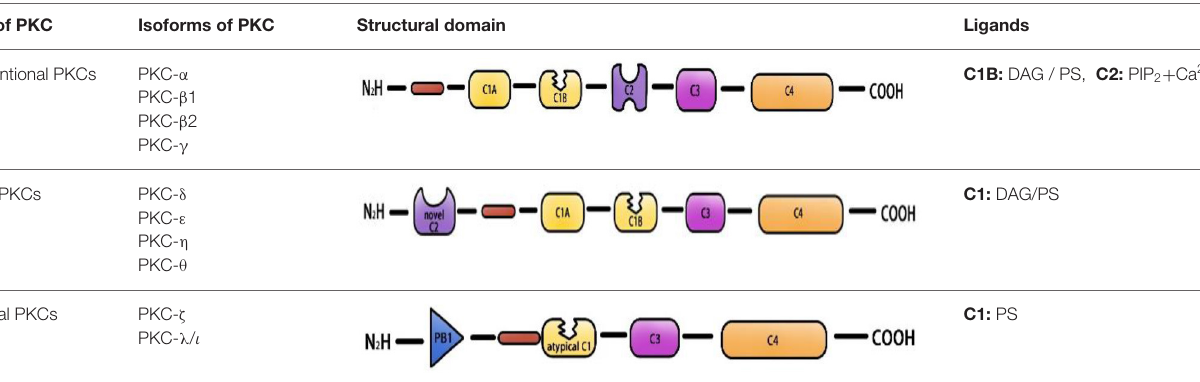
TABLE 1 | PKC isoform sub-family